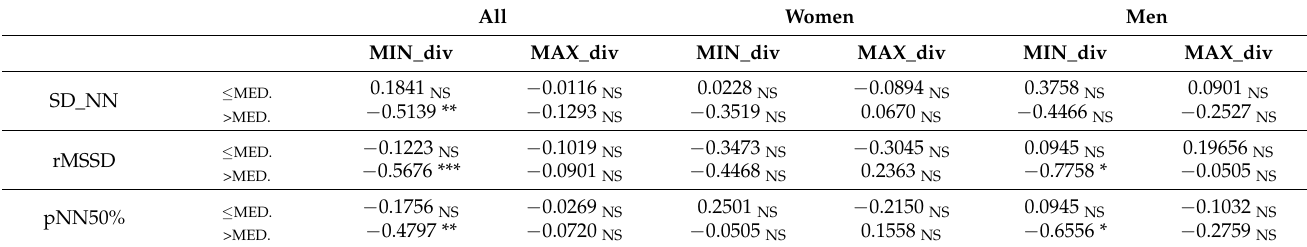
Table 7. Correlation coefficients between MIN_div and the selected parameters of HRV in the time domain. All Women Men